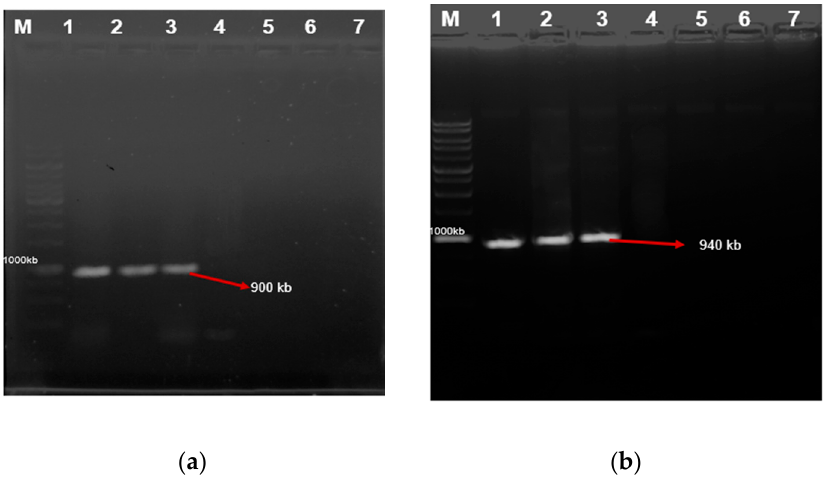
Figure 4. Transillumination image of PCR fragments showing agarose gel electrophoresis bands of ( a ) hexon and ( b ) fiber genes. Lane 1, FAdV Hexon positive control; Lane 2, UPM08136CELP5B1; lane 3, UPM08136PCELP20B1; Lane 4 negative control; M, molecular weight DNA marker (1kb DNA ladder, Promega). Red labels show the band